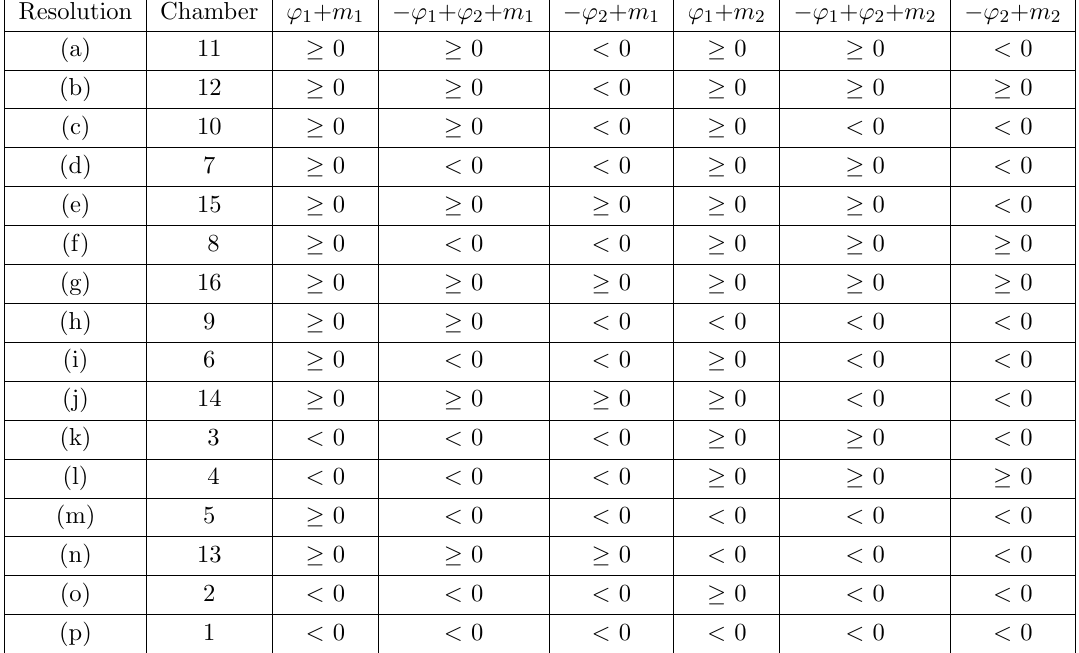
Table 4 . The map between the 16 crepant resolutions of the E 32 ; 1 singularity that admit a vertical reduction, and the 16 chambers of the SU(3) 2 N f = 2 (cid:12)eld theory, with (cid:12)eld theory chamber de(cid:12)nitions expressed as